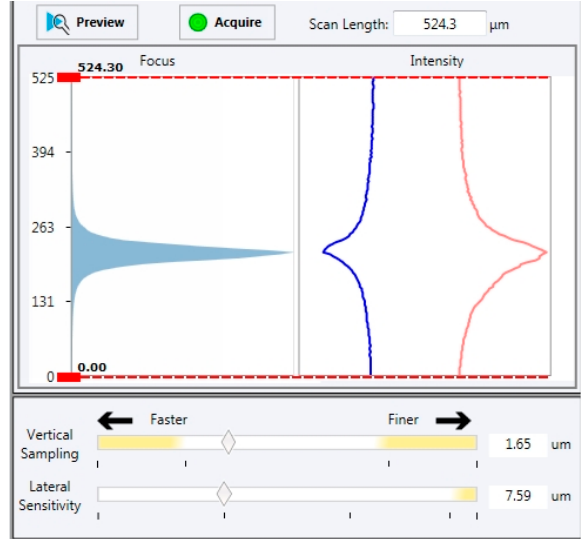
Figure 5. Contour LSK Bruker Interface. Histogram on the left represents the focus information curve. On the right, blue curve represents the lower intensity of pixels and the red one the higher intensity.